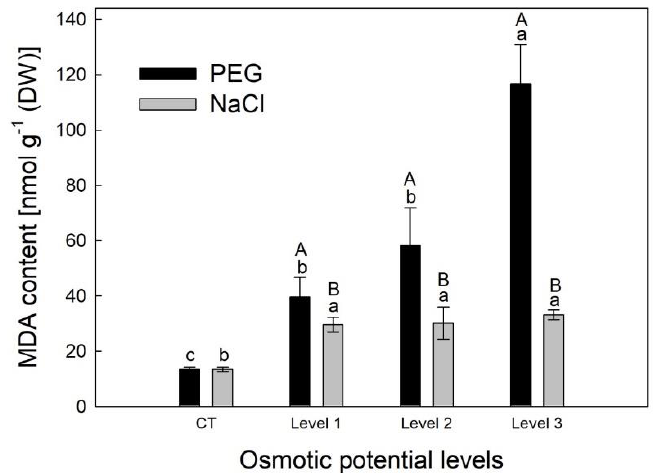
Figure 5. Means ± SD (n = 3) of the malondialdehyde (MDA) content of leaves collected from seedlings grown under three iso-osmotic potential levels under separate PEG and NaCl treatments. Level 1: 24% (w/v) PEG and 200 mM NaCl; Level 2: 26.5% (w/v) PEG and 250 mM NaCl; Level 3: 29% (w/v) PEG and 300 mM NaCl. Means with different lowercase letters significantly differ in an LSD test under different PEG or NaCl concentrations, respectively ( p < 0.05). Means with different capital letters significantly differ in a t -test between PEG and NaCl concentration at the same osmotic potential.